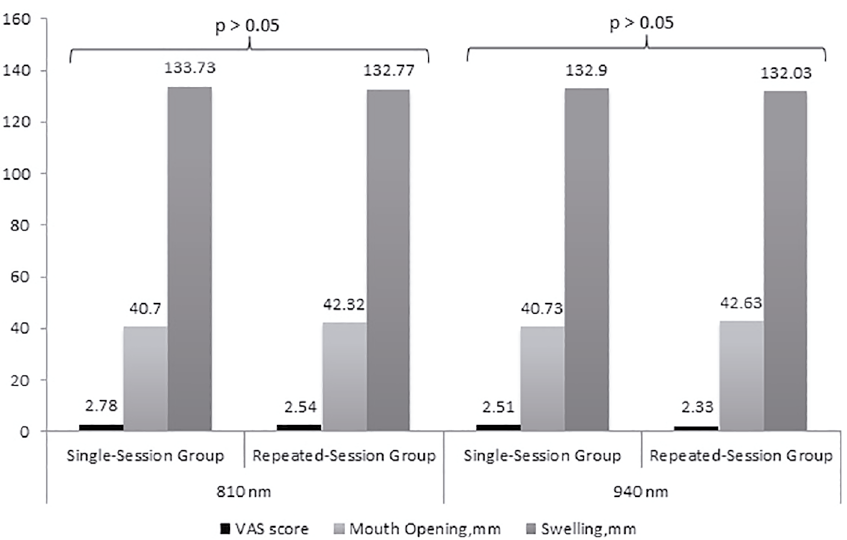
Figure 3- Results of the comparisons of the single- and repeated session groups in terms of visual analog scale scores, maximum mouth opening, and degrees of swelling for application at 810 nm and at 940 nm